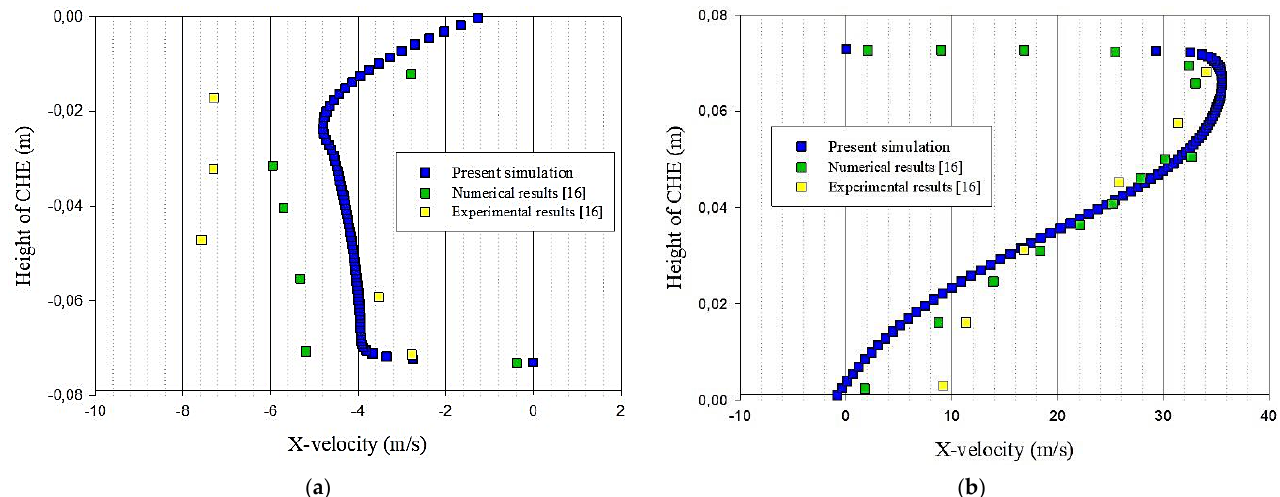
Figure 2. Axial velocity curves at Re = 8.73 × 10 4 and x = 0.525 m: Validation against experimental data. ( a ) Lower side of the CHE. ( b ) Upper side of the CHE.